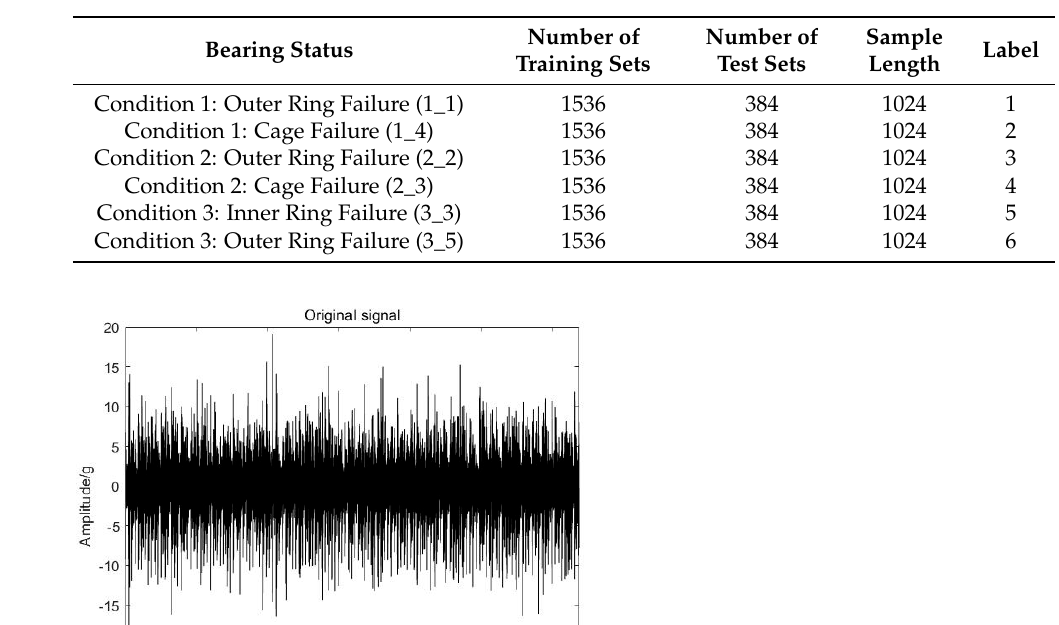
Table 4. XJTU-SY Dataset Description.